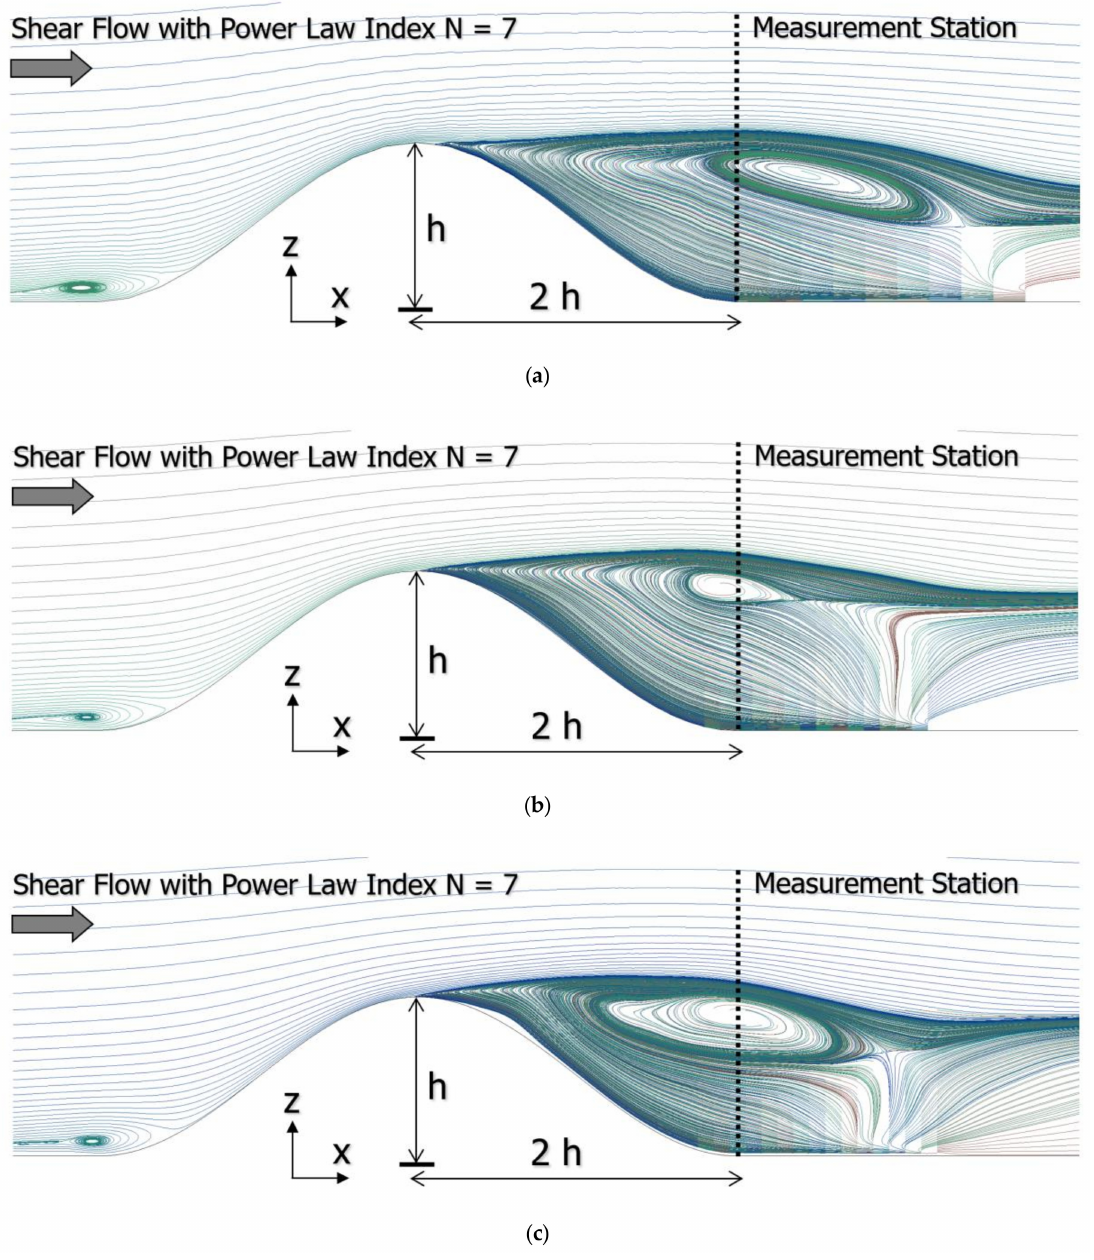
Figure 5. Comparison of streamlines for a time-averaged flow field under neutral conditions in the case of a steep hill. ( a ) Coarse grid: 151 × 101 × 51; ( b ) Medium grid: 301 × 201 × 51; ( c ) Fine grid: 601 × 401 ×